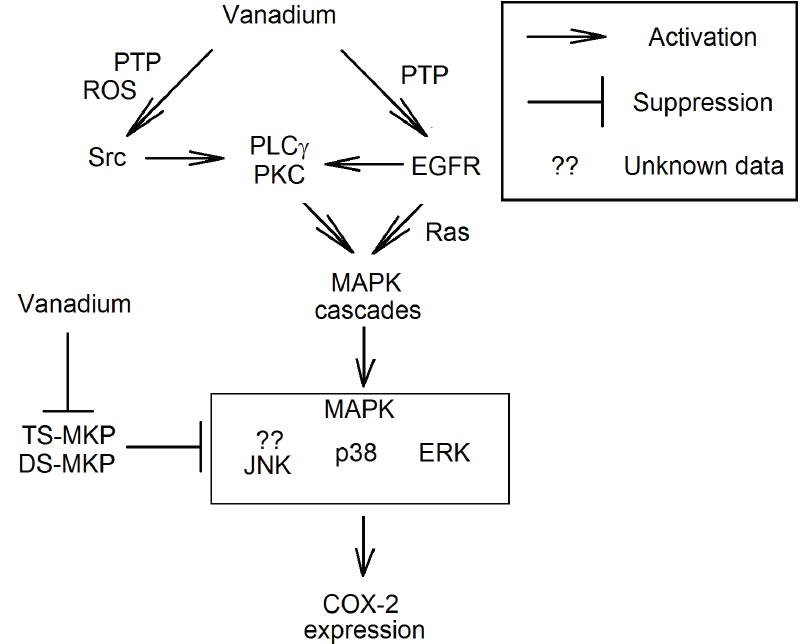
Figure 3. The mechanism of the activation of mitogen-activated protein kinase (MAPK) cascades in the expression of COX-2 by vanadium compounds. Vanadium compounds are the inhibitors of PTPs which directly affect the activity of Src, as well as epidermal growth factor receptor (EGFR) and MAPK. The activation of Src results in the phosphorylation